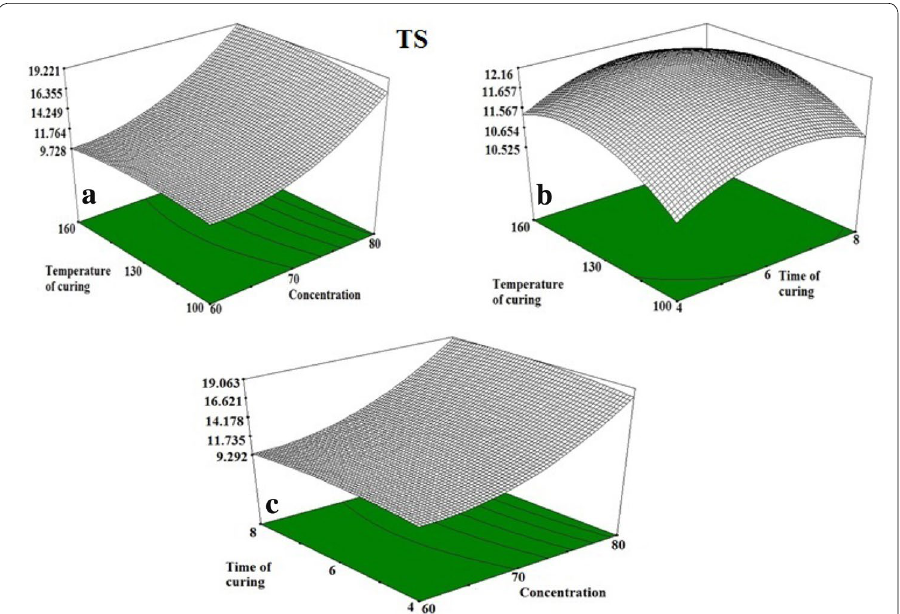
Fig. 4 Effect of process variables on TS of treated cotton. a Temperature of curing & Concentration. b Tem- perature of curing & Time of curing. c Time of curing &